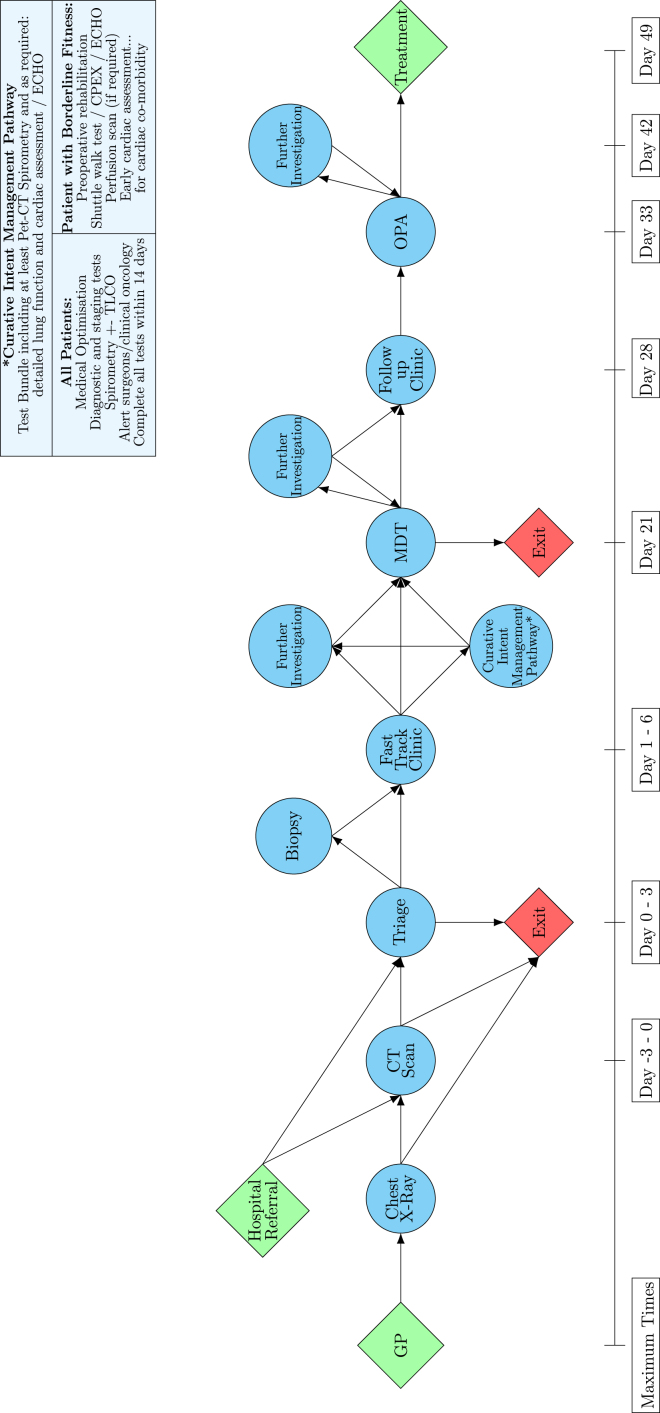
Simplified National Optimal Lung Cancer Pathway.